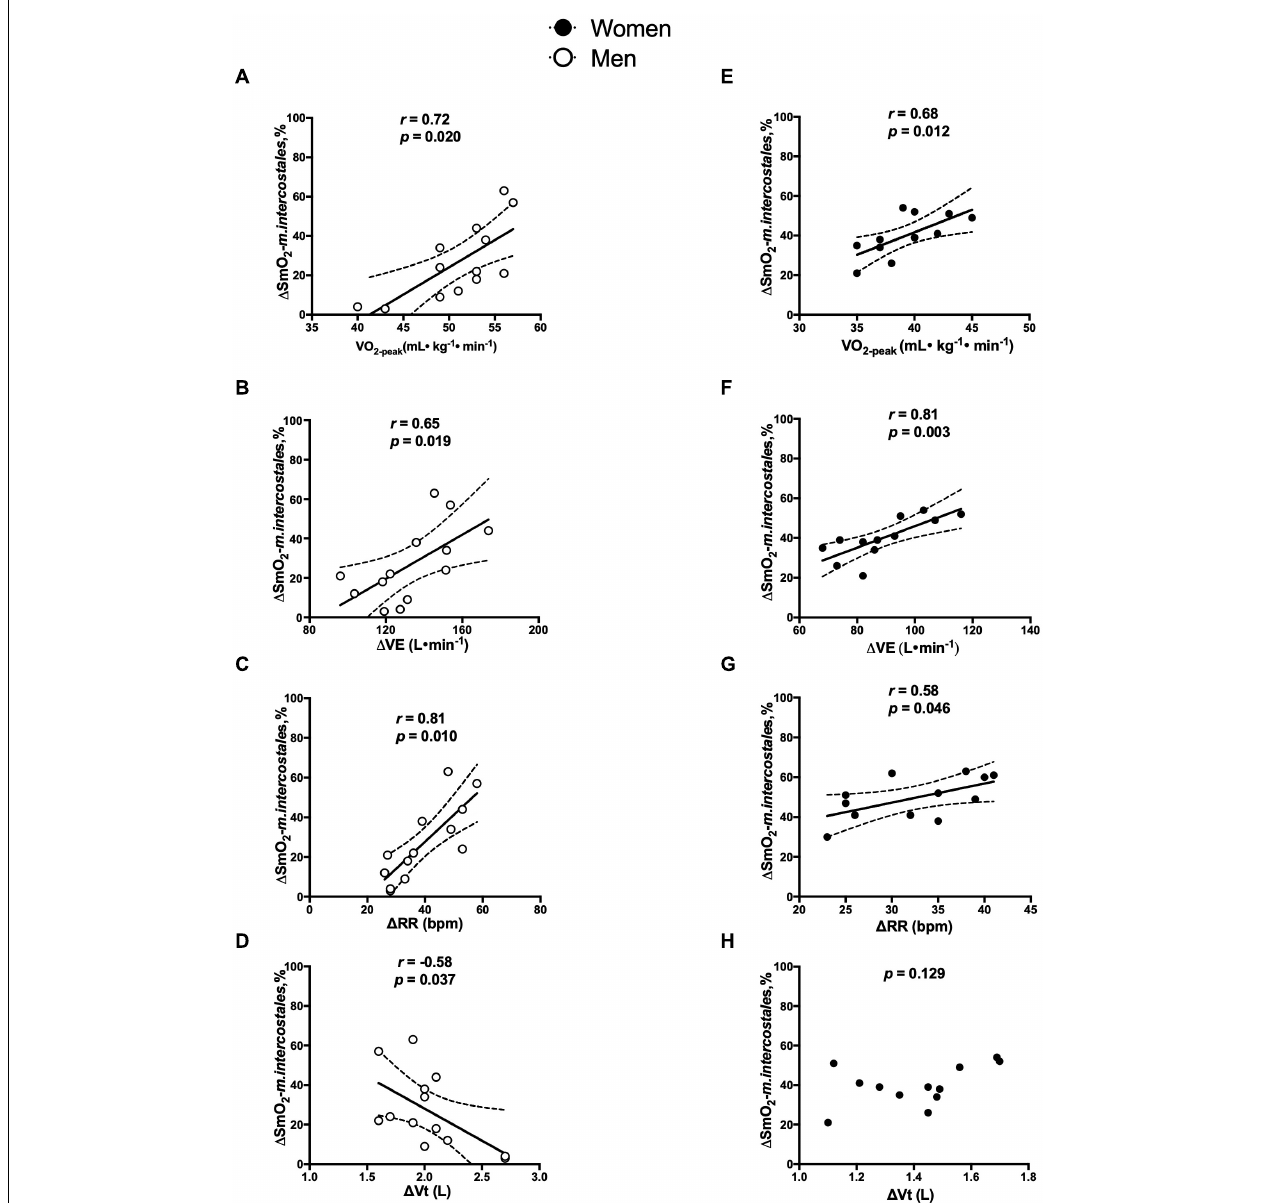
FIGURE 5 | Correlation in men and women between (cid:49) SmO 2 - m.intercostales with: (A,E) ˙ VO 2 - peak (ml · kg − 1 · min − 1 ), (B,F) (cid:49) ˙ VE ( ˙ VE peak— ˙ VE rest phase, L · min − 1 ), (C,G) RR (RR peak – RR rest phase, breaths · min − 1 ) and (D,H) Vt (Vt peak – Vt rest phase,